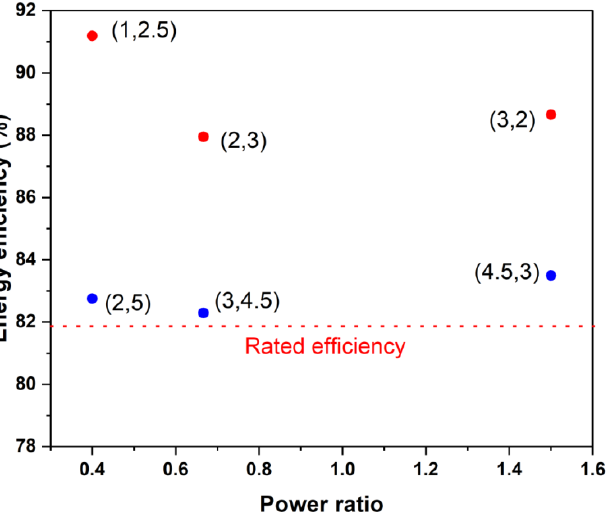
Figure 11. Estimated round-trip efficiency of the present stack for different power ratios and power levels if operated in an SoC range between 20% and 80%. The numbers in brackets indicate (charging power and discharging power), with both in kW.